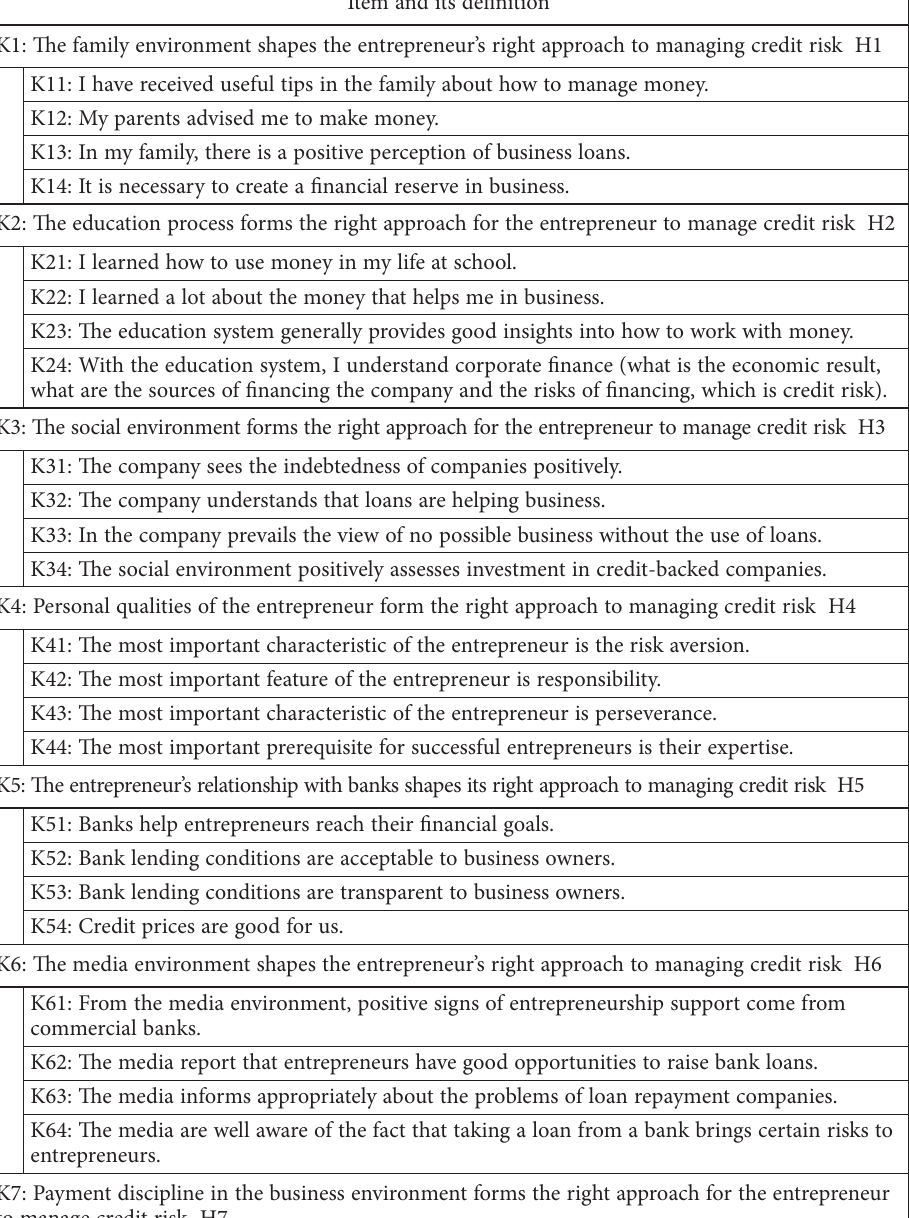
Table 1. Examined constructs (K) and the quality characteristics (Kxx) (source: own processing) Item and its